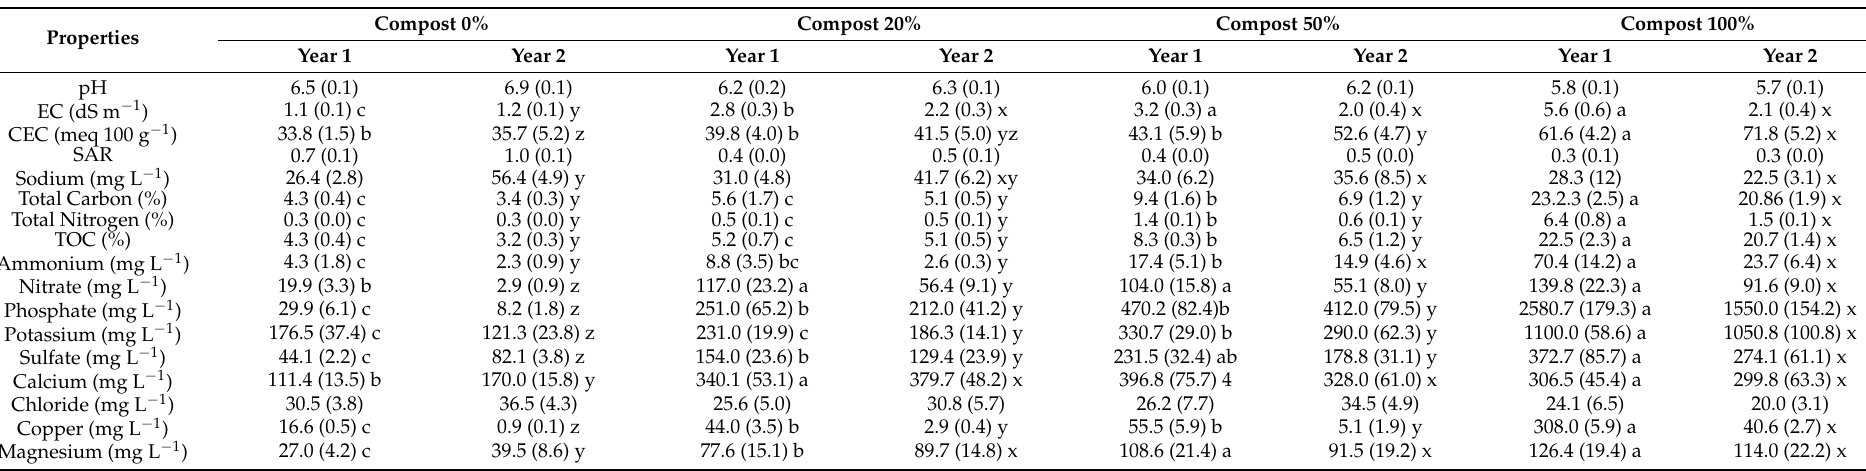
Table 3. Mean ( ± SE) soil properties by soil amendment treatments. Different letters indicate significant differences among amendment treatments in